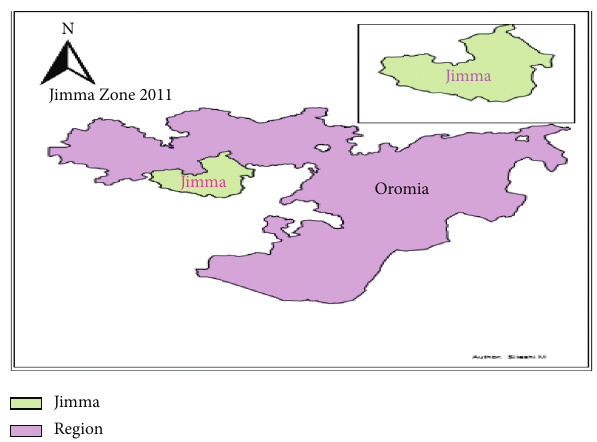
Figure 1: Map of the Jimma Zone in the Oromia Region, Ethiopia